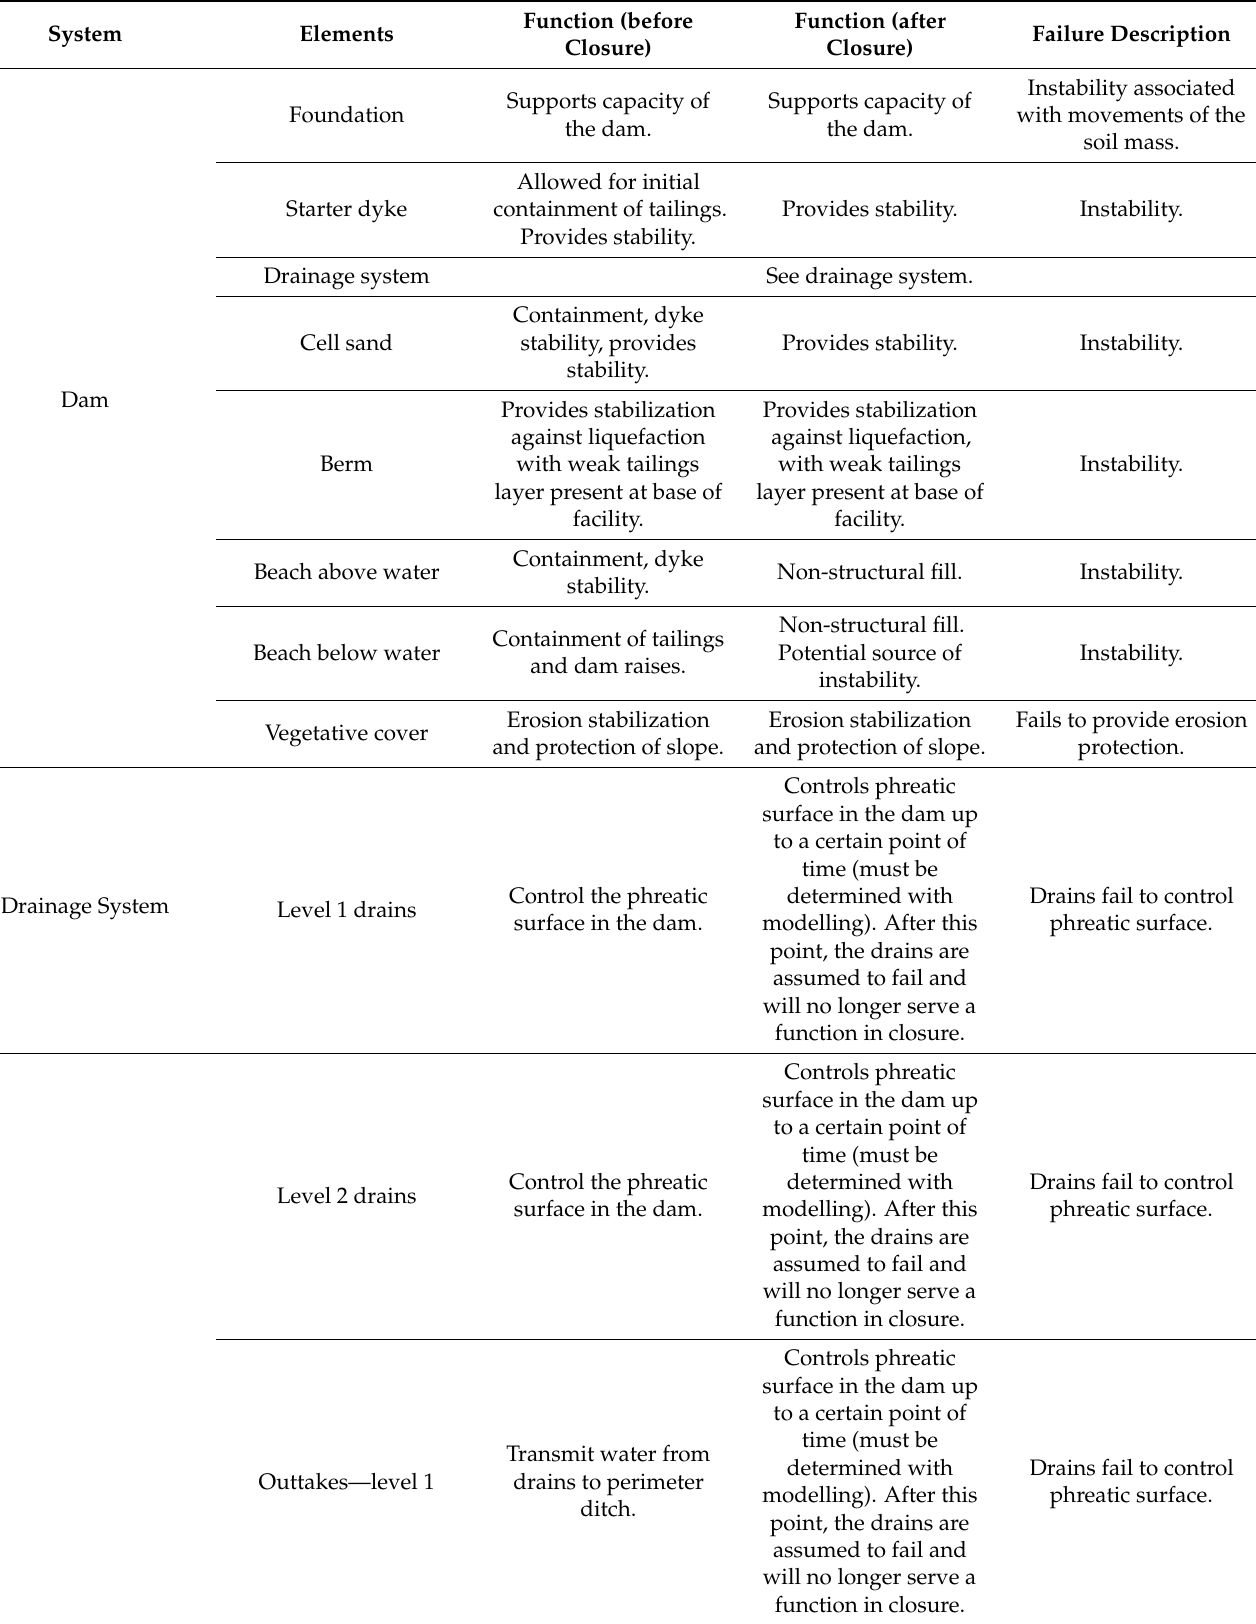
Table 4. Case study element functions and failure